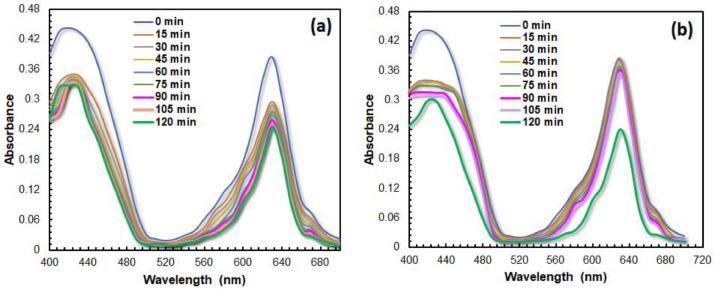
The time dependent absorption spectra of BG (10 ppm) upon photodegradation using CaTiO3 with CaCO3/TiO2 molar ratio of (a) (1:3) and (b) (2:7). The amount of catalyst was fixed at 50 mg.